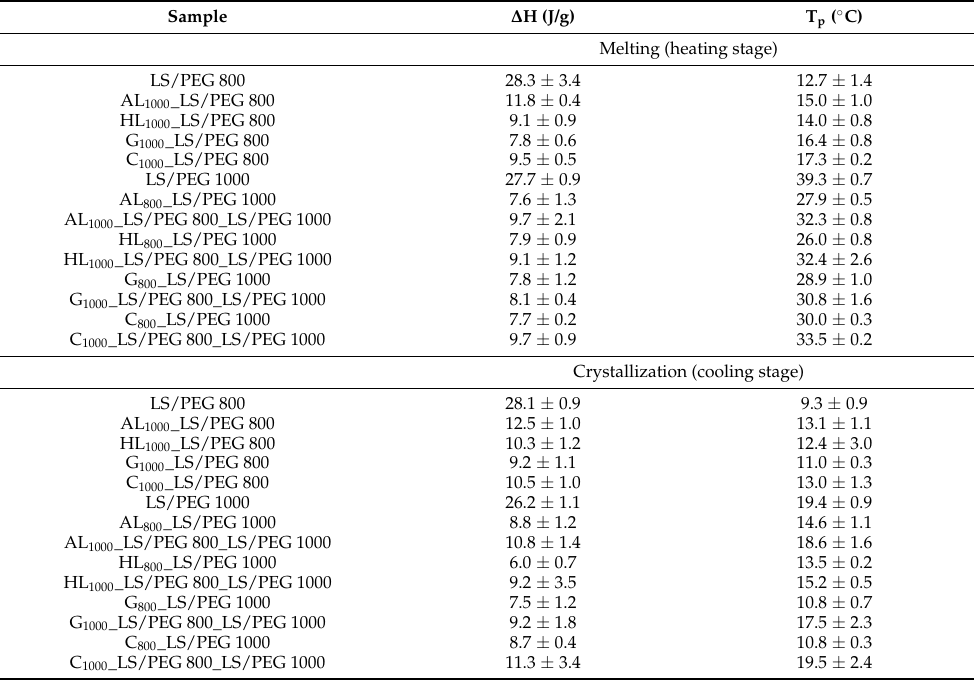
Table 3. Results of DSC tests performed on LS/PEG 800 and LS/PEG 1000 composites and on mortars containing a PEG-based PCM. ( ∆ H: enthalpy measured during melting or crystallization processes. T p : peak temperature of melting or crystallization